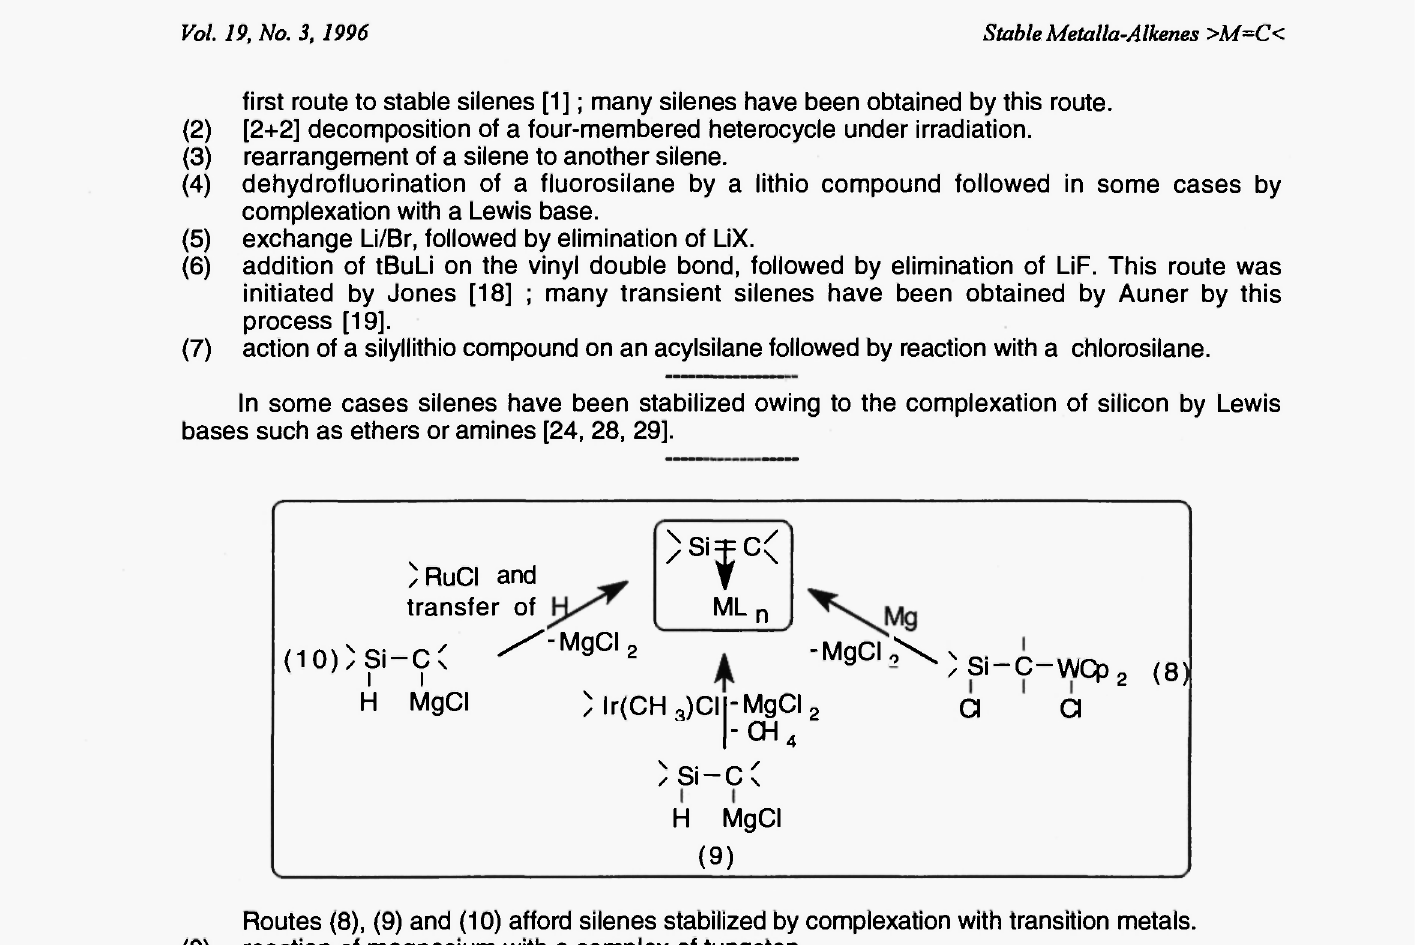
Table 1 : SILENES SILENES